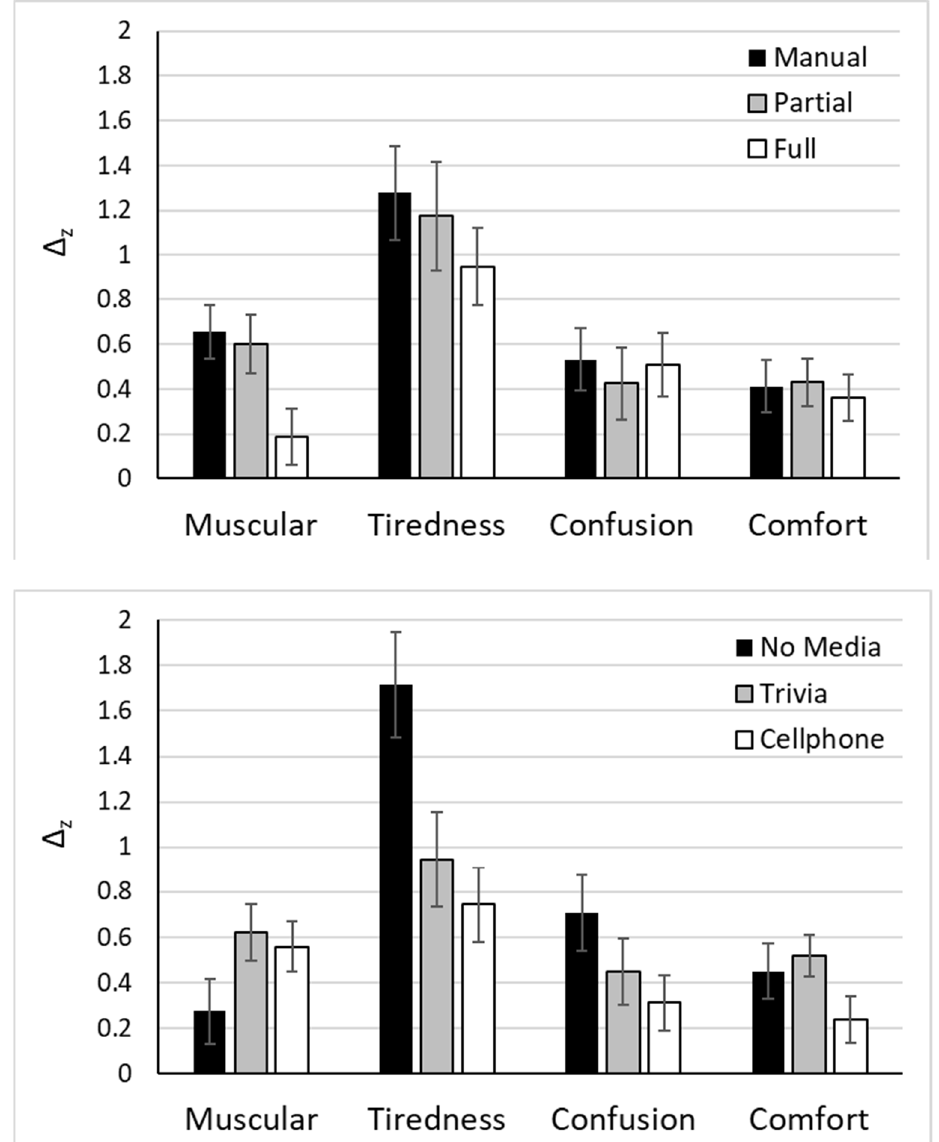
Figure 4. Mean standardized change scores on four state fatigue dimensions as a function of (1) automation condition ( upper panel ) and (2) secondary media condition ( lower panel ). Error bars are standard errors.